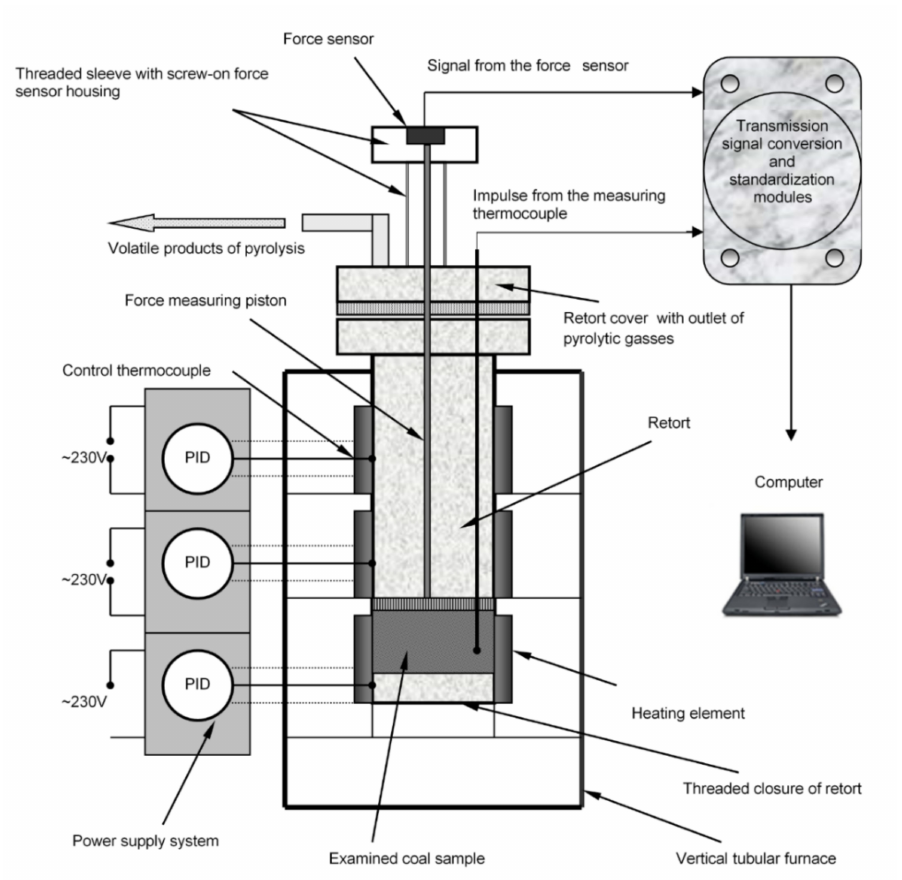
Figure 2. Laboratory equipment for examinations of coking pressure generated by the layer of plasticized coal grains during the coking